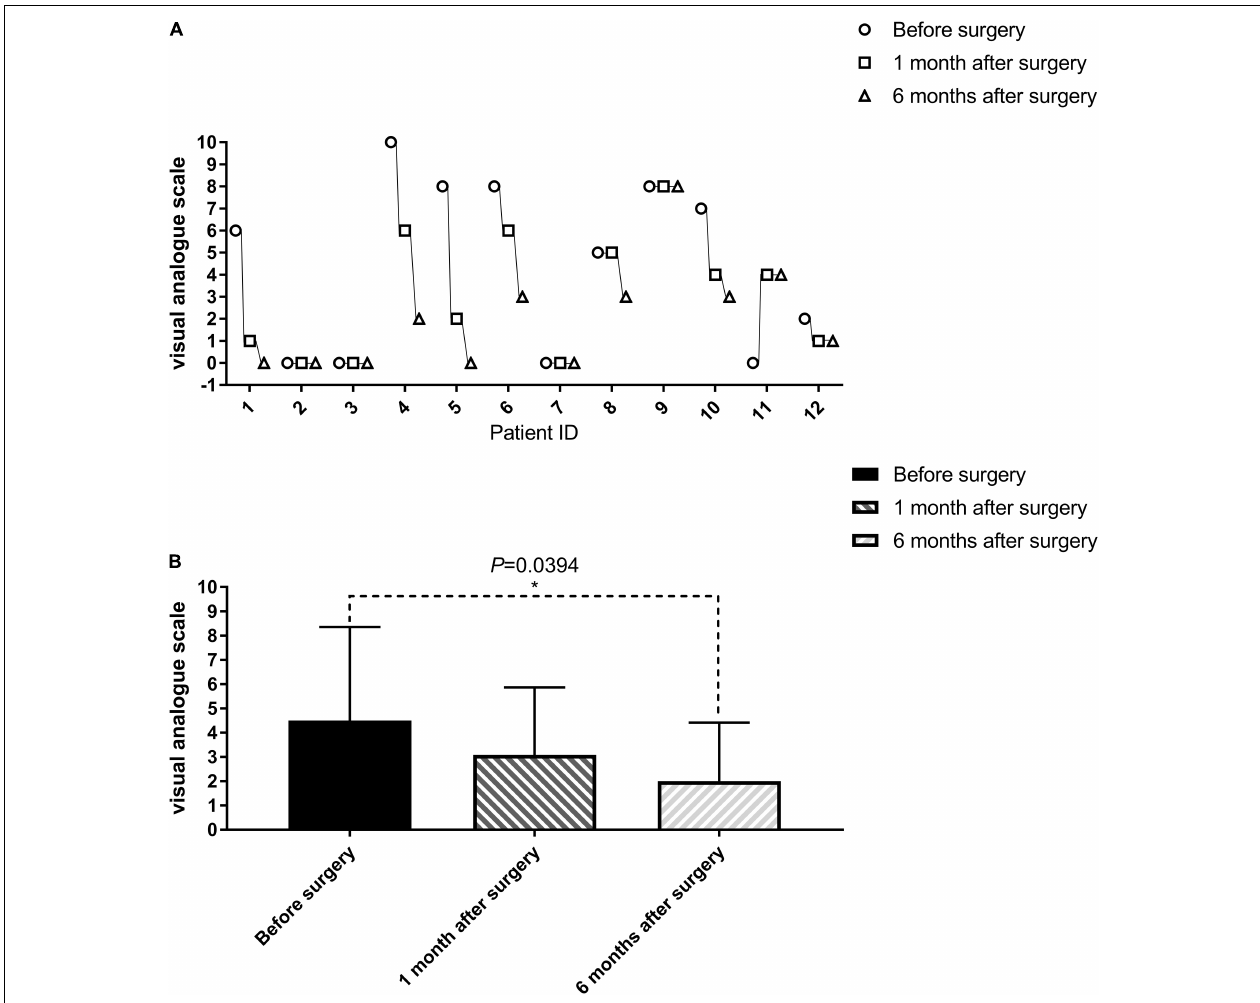
FIGURE 4 | Evaluation of cord central pain in patients with paraplegia before, 1 and 6 months after the surgery (visual analog scale, VAS). The VAS of one patient (SCF011) who had no spinal central pain before the surgery developed after the SNT. The VAS of seven patients (SCF001, SCF004, SCF005, SCF006, SCF008, SCF010, SCF012) after the surgery gradually decreased compared with that before the surgery. The remaining patients were unchanged (1–12 on the horizontal axis represents SCF001-SCF012, see in (A) . The difference between VAS before and 6 months after the surgery was statistically significant by a paired sample t -test, p < 0.05 (B)